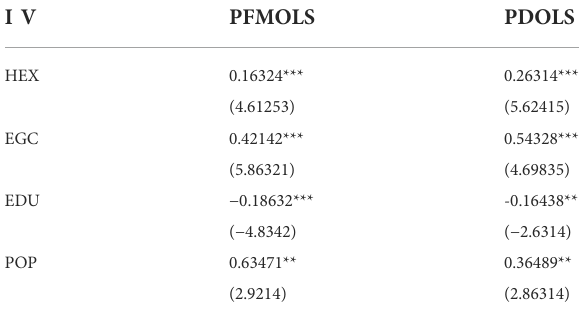
TABLE 6 PFMOLS and PDOLS results.